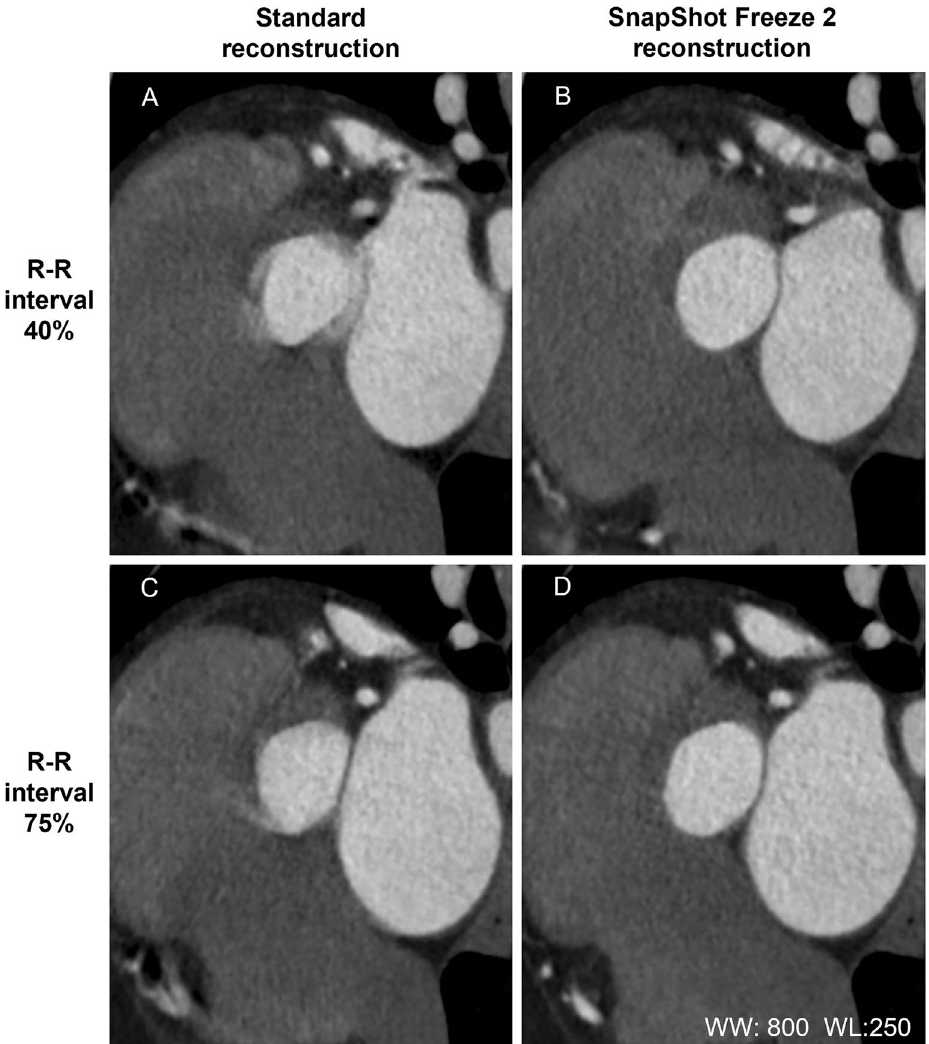
Figure 6. Clinical image of SSF2. In their 80 s (height = 157 cm, body weight = 58 kg, body mass index = 23.5 kg/ m 2 ), heart rate during the scan = 116 bpm (atrial fibrillation). ( A ) and ( C ): MPR images of the aortic annulus (R-R interval = 40% and 75%) using standard reconstruction. The visualization scores for ( A ) and ( C ) were 1 and 2, respectively. ( B ) and ( D ): After SSF2 reconstruction, both visualization scores were 4. The evaluable image quality improved. WW = window width; WL = window